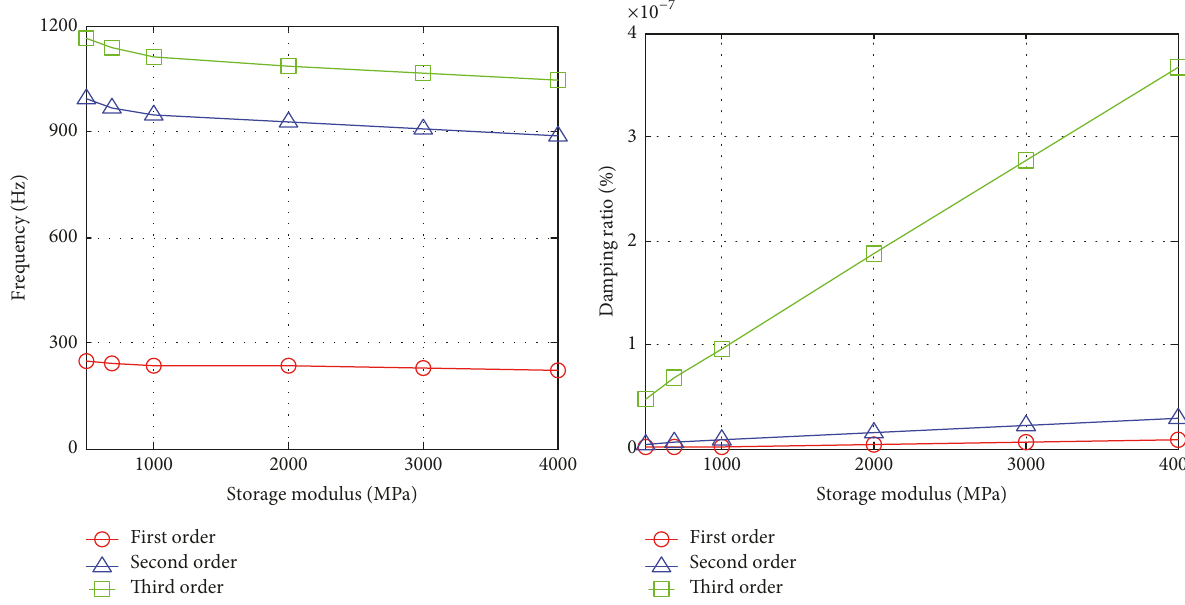
Figure 8: Natural frequencies and modal damping ratio of the blade under the influence of storage